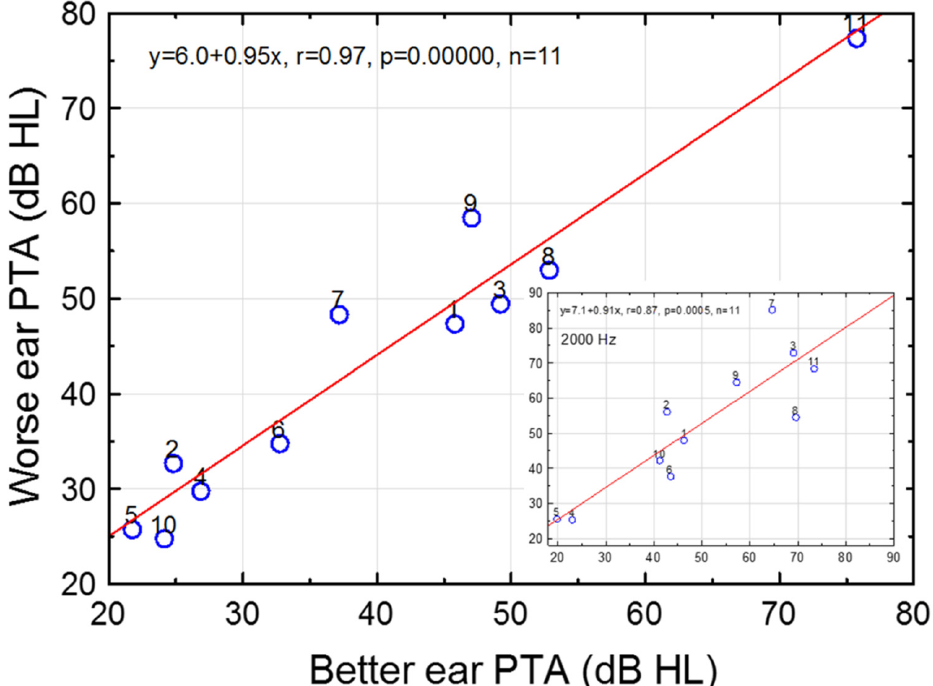
Figure 2. Pure-tone average (PTA, 500-2000 Hz) in worse versus better ear for all the participating subjects (1–11, numbered in testing order). Linear regression revealed worse ear PTA (dB HL) = 6.0 + 0.95 · better ear PTA (dB HL), r = 0.97, p = 0.00000 (n = 11). Inset depicts worse ear versus better ear pure-tone threshold at 2000 Hz (dB HL, n = 11). Note that 4 subjects had PTAs <30 dB HL in the better ear (2 subjects revealed PTTs <30 dB HL at 2000 Hz), thus reflecting the highly efficient